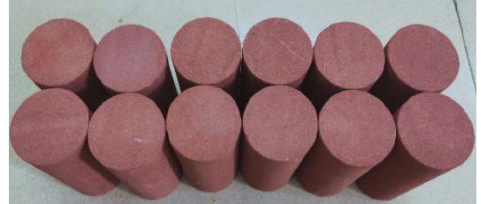
Figure 1. Some red-bed soft rock specimens.